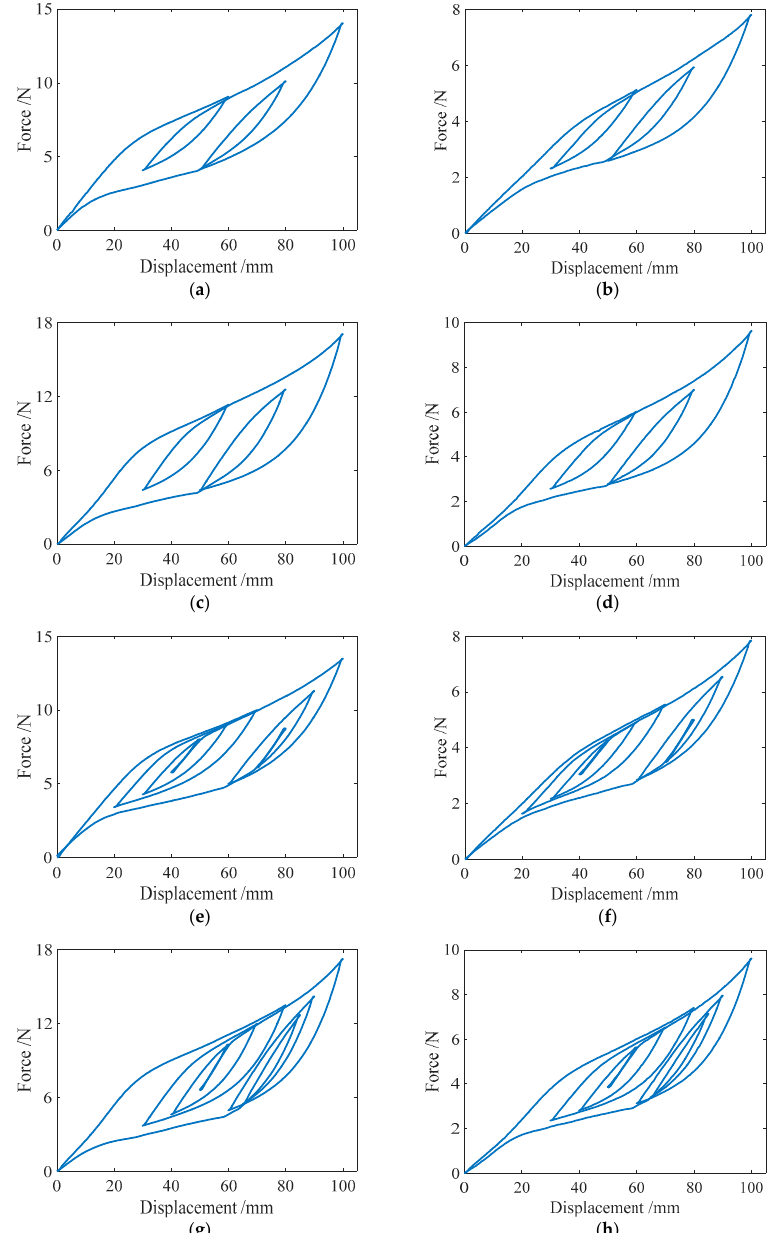
Figure 10. Force-displacement relationship curves of the spring specimens under complex single-cycle loading:( a ) SMA-S1 in Case III; ( b ) SMA-S2 in Case III; ( c ) SMA-S3 in Case III; ( d ) SMA-S4 in Case III; ( e ) SMA-S1 in Case IV; ( f ) SMA-S2 in Case IV; ( g ) SMA-S3 in Case IV; ( h ) SMA-S4 in Case